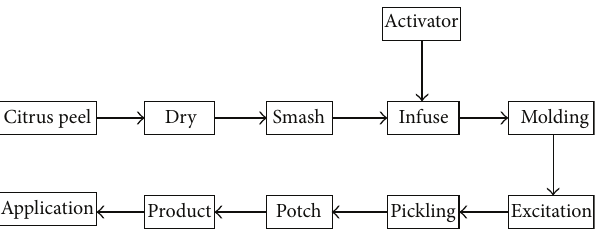
Figure 1: Preparing process of activated carbon from orange peel.